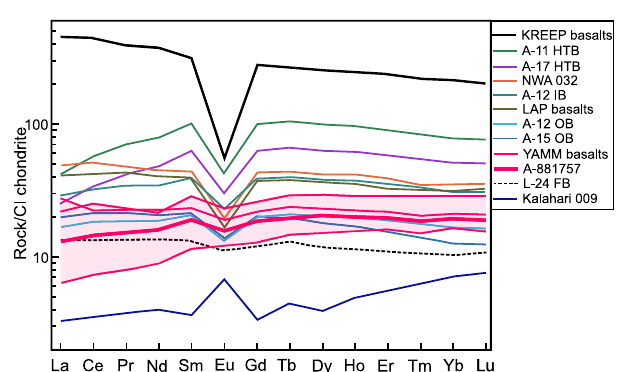
Fig. 3 | Measured REE abundance ofA-881757 compared withother YAMM and lunar basalts. Chondrite-normalized rare earth element plots for YAMM (magenta), Kalahari 009 (blue), Luna 24 ferrobasalts (FB; dashed line), NWA 032 (orange), LAP basalts (olive green), along with Apollo 12 and Apollo 15 olivine basalts,Apollo12ilmenitebasalts,Apollo11andApollo17high-TibasaltsandKREEP basalts. YAMM basalts along with Luna 24 ferrobasalts and Kalahari 009 show depleted REE pattern while there is a lack of prominent Eu anomaly in YAMM and Luna 24 ferrobasalts, which are distinct from Apollo mare and KREEP basalts. Data Sources: A-881757 (this study); Y-793169 (ref. 16); MIL 05035 (ref. 20); MET 01210 (ref. 75); Luna 24 ferrobasalts 14 ; Kalahari 009 (ref. 18); Apollo and KREEP basalts 19 .